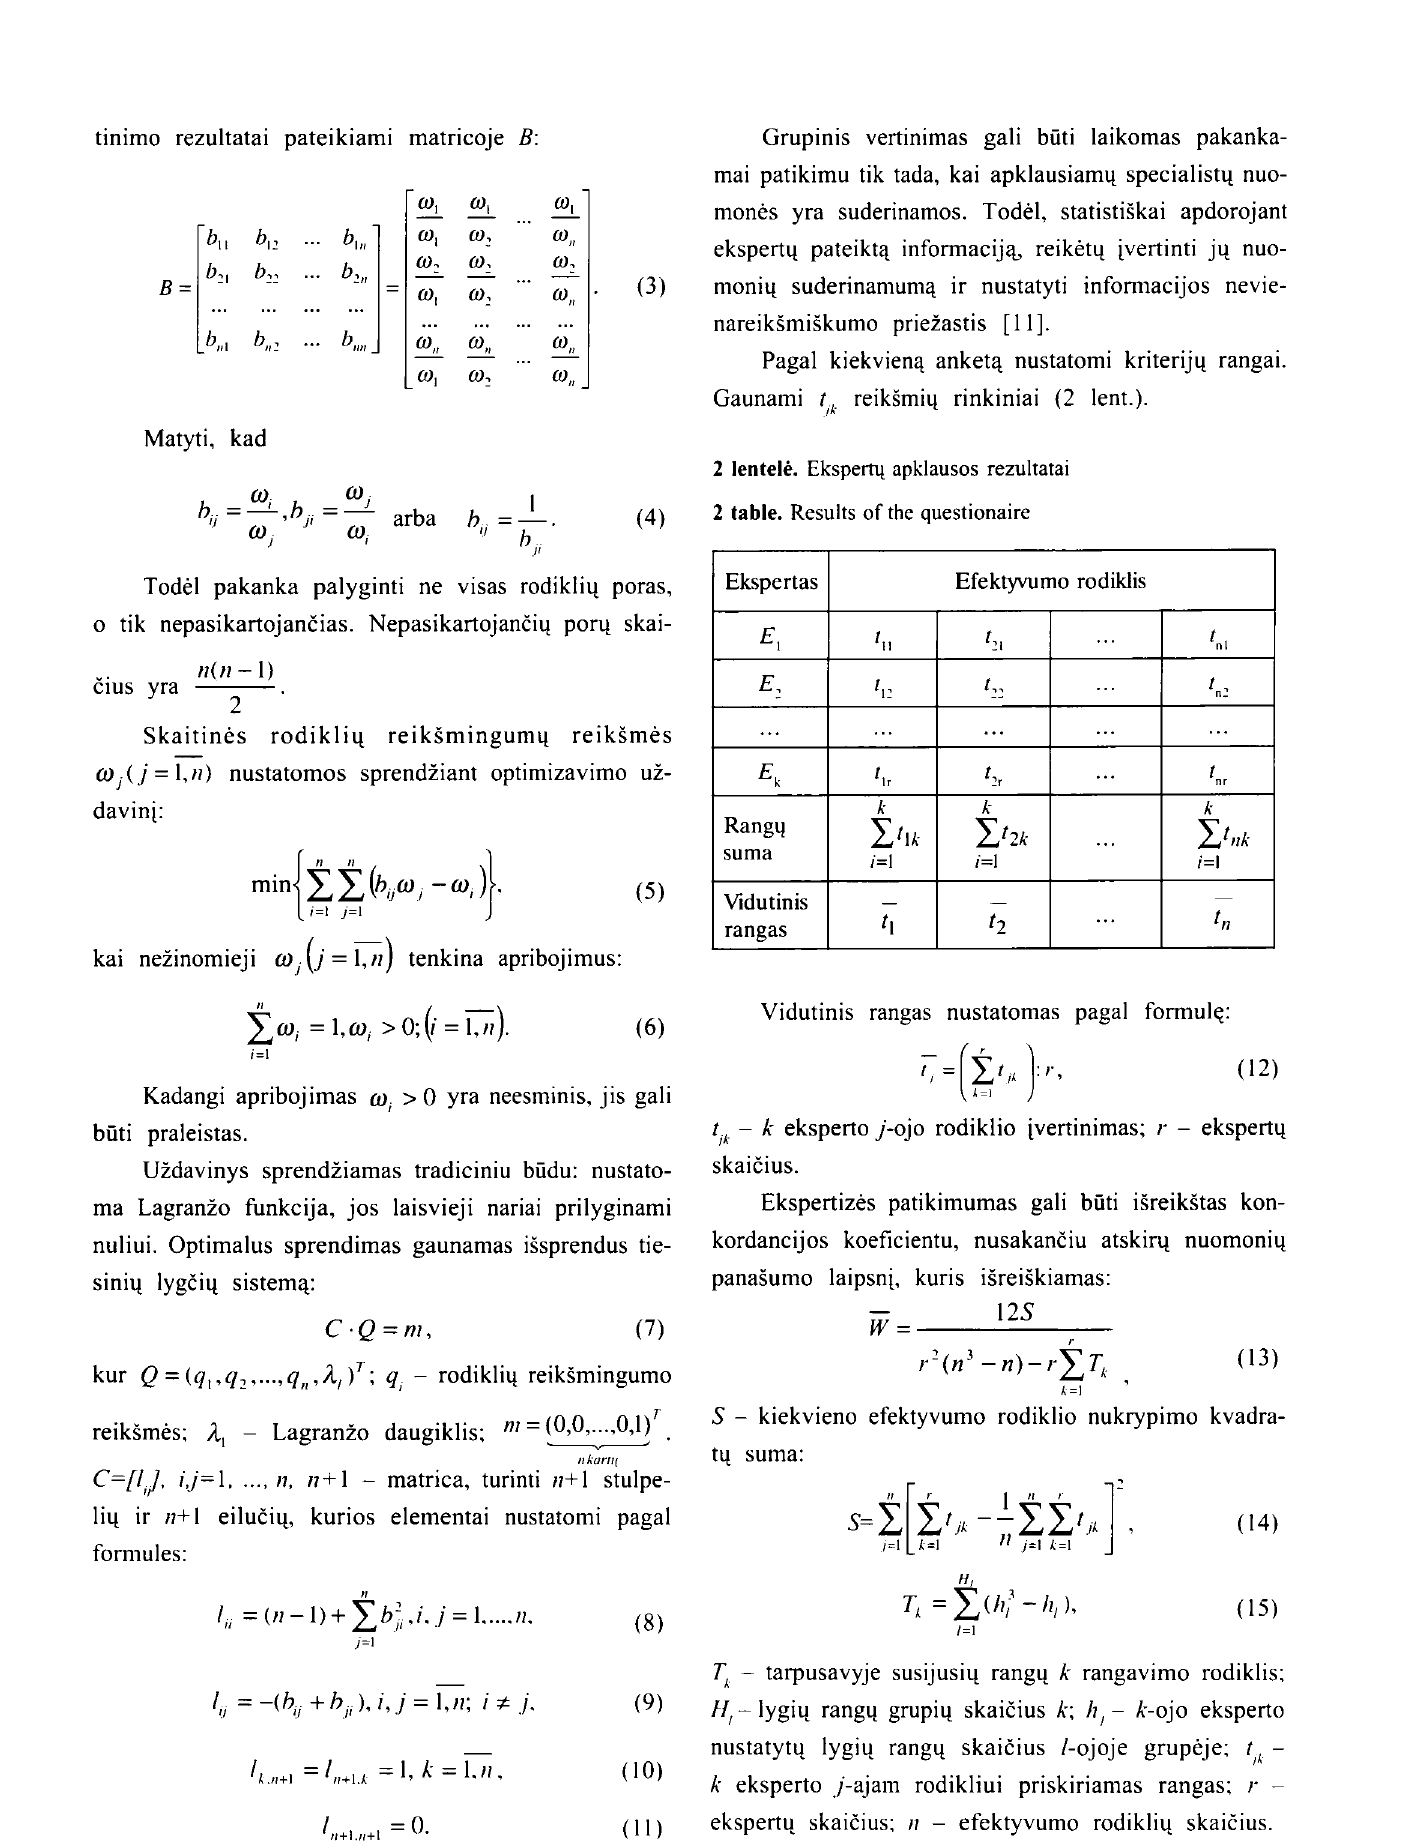
Ekspertizes patikimumas gali biiti isreikstas